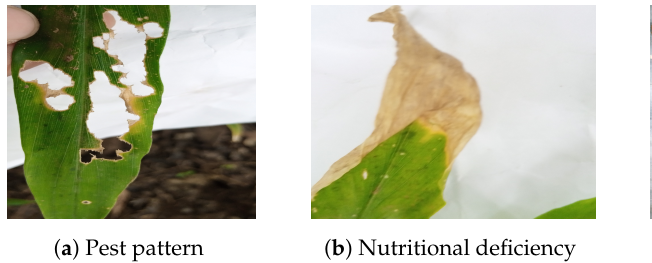
Figure 4. Sample input data of ginger plant